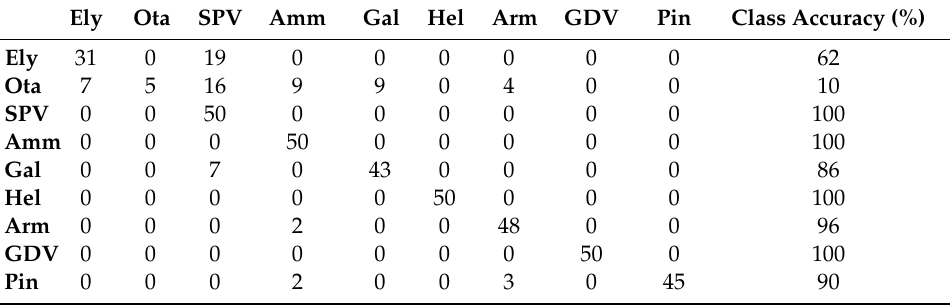
Table 4. Confusion matrix of the first RF classifier for the nine vegetation